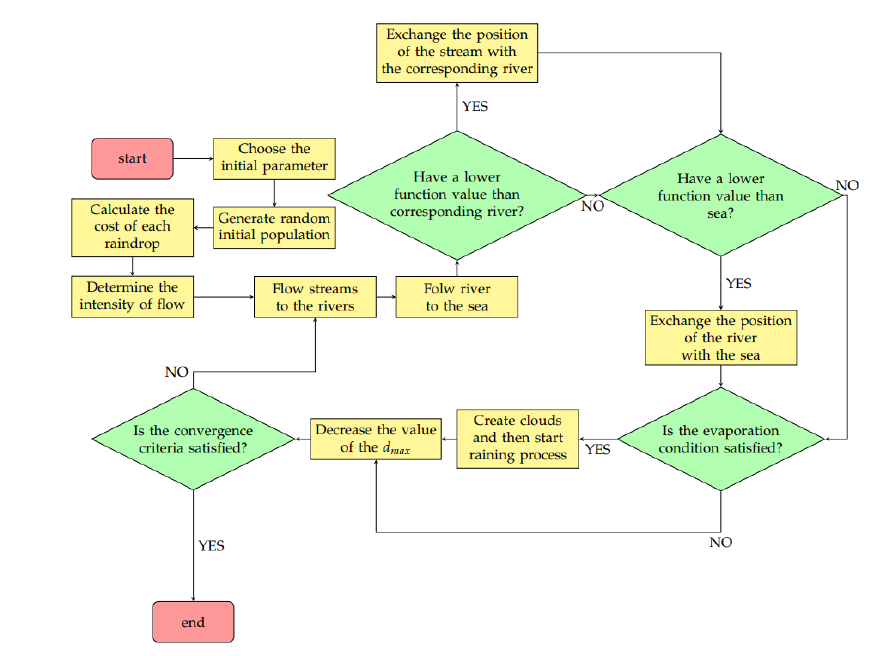
Figure 2. The flow chart of